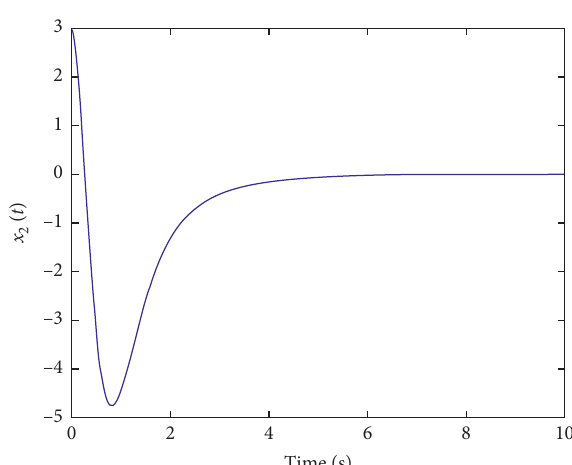
Figure 4: Responses of x